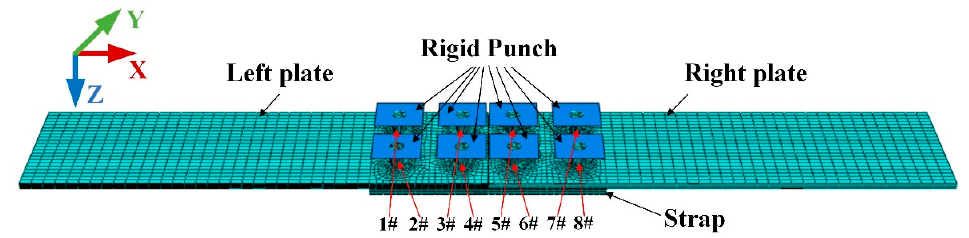
Figure 7. The finite element model of riveted single strap butt joint. The punches are set as rigid bodies and 1#–8# are the numbers of the rivets.